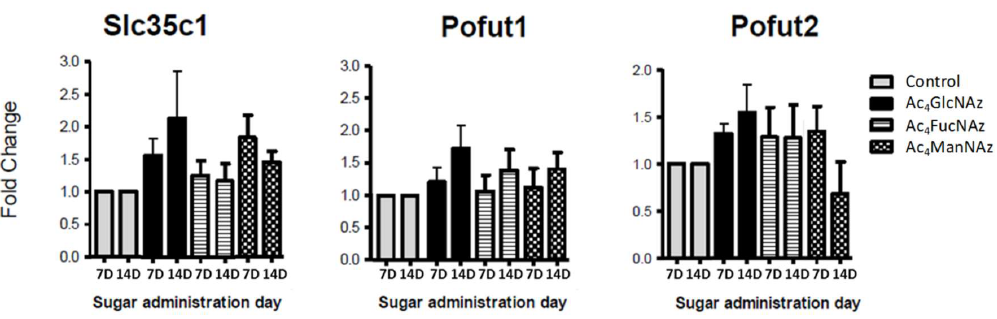
Figure 6. Fucose transporter and transferases gene expression after 7 and 14 days in culture (7D and 14D).